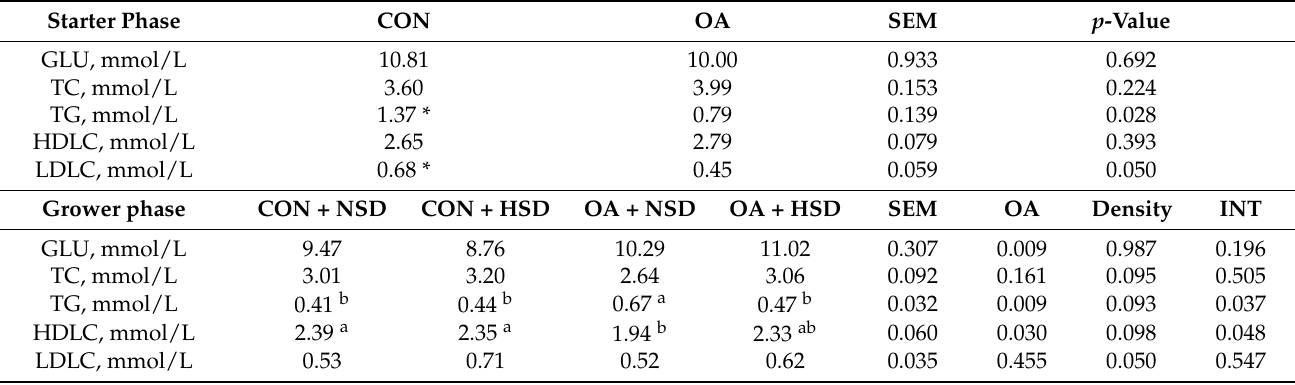
Table 2. Effects of organic acids on serum lipid metabolism profiles in broilers at starter and grower phases 1 .